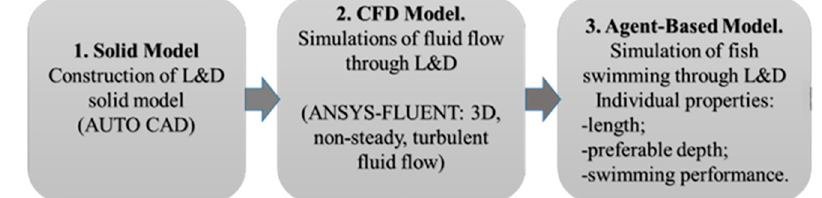
Figure 1. Flow chart of stages used by the algorithm computational fluid dynamics agent-based (CFD-AB) model.